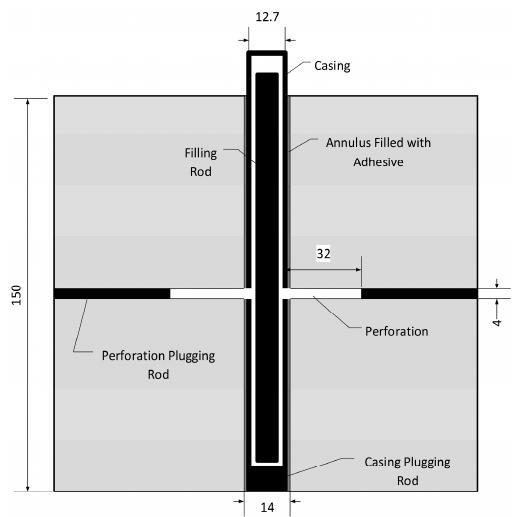
Figure 2. A schematic of 150 mm cubic sample with a cased wellbore at the center and two 4 mm perforations that are perpendicular to the axis of the wellbore and at an angle of 180° from each other (all dimensions are in mm).